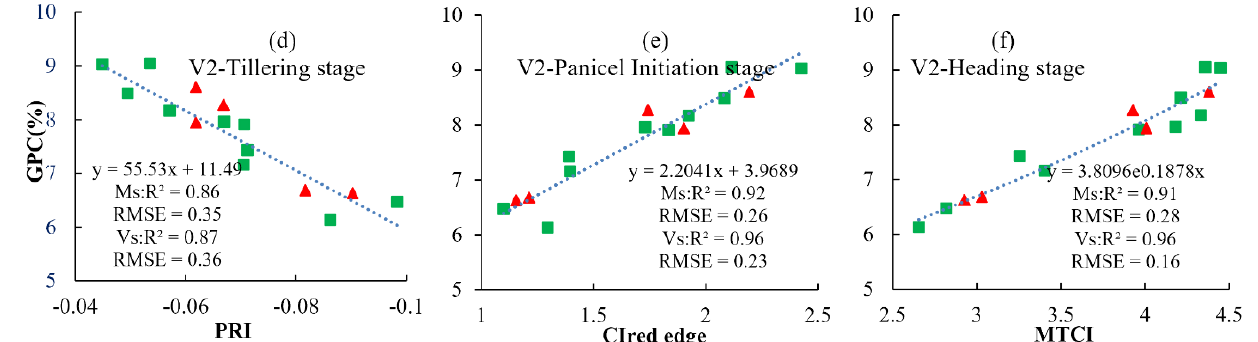
Figure 9. Scatterplots and regression models of grain protein content (GPC) and optimal monitoring parameters for different growth stages for variety V1 (Meixiangzhan 2) at ( a ) the tillering stage, ( b ) panicle initiation stage, and ( c ) heading stage; and for variety V2 (Wufengyou 615) at ( d ) the tillering stage, ( e ) panicle initiation stage, and ( f ) heading stage.